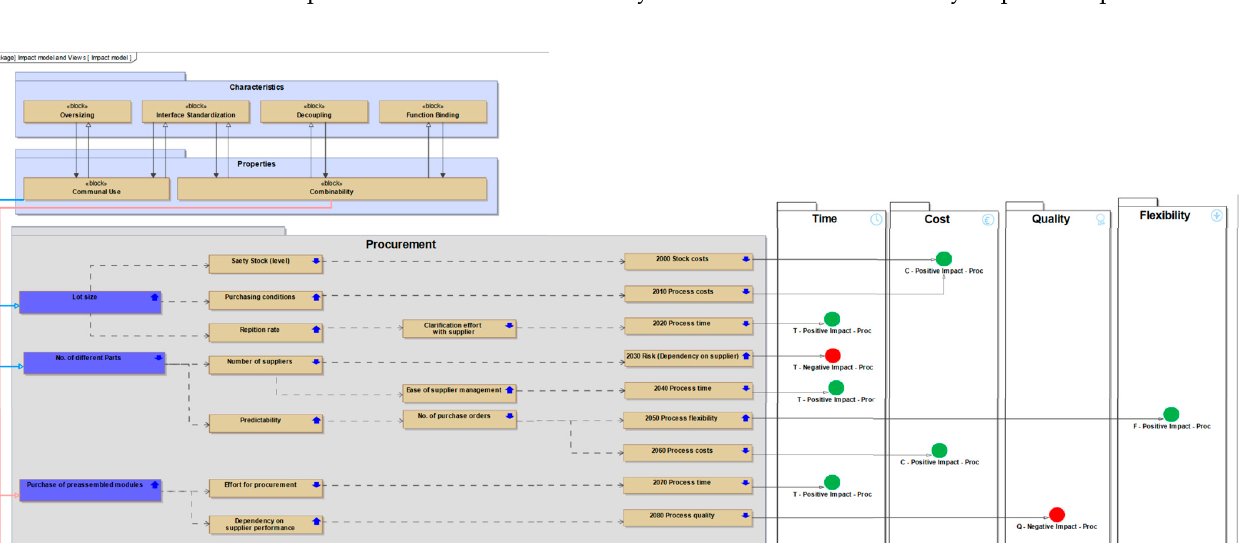
Figure 4. Extract of the block definition diagram of the IMF in Cameo Systems Modeler (Sys-IMF) for the life phase of procurement.